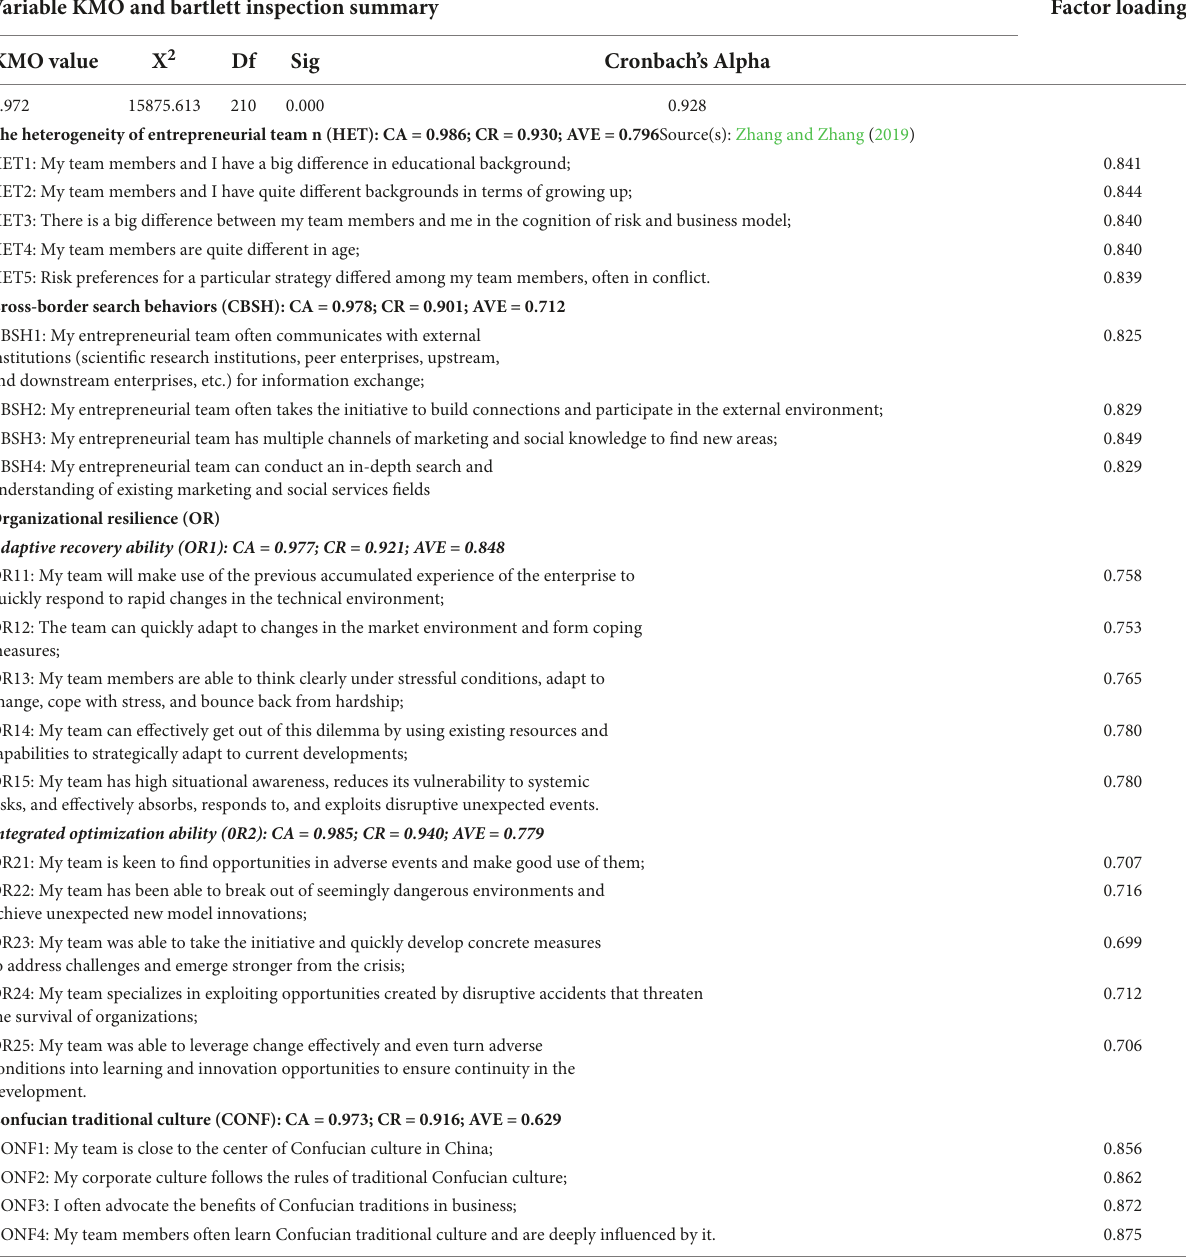
TABLE 2 Confirmatory factor